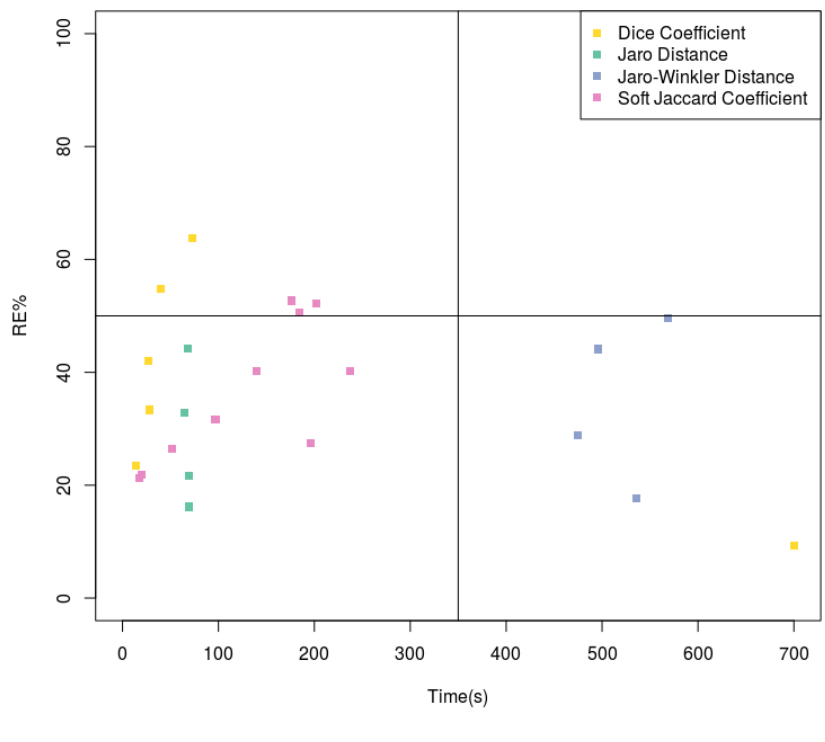
Figure 9. Recall over time. Top left corner shows the best performance.